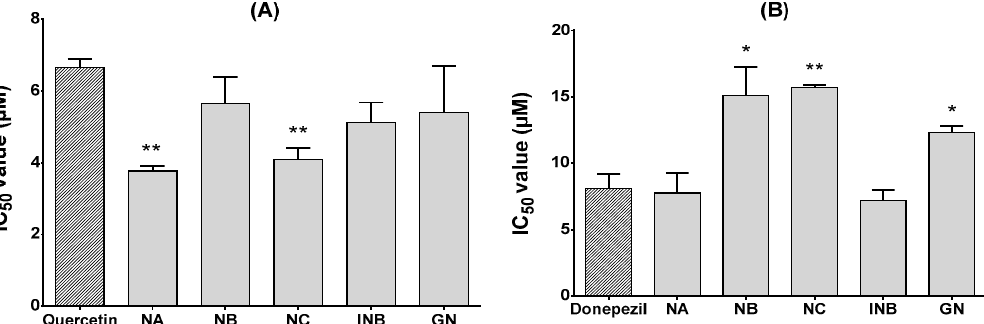
Figure 4. The α -glucosidase ( A ) and acetylcholinesterase ( B ) inhibitory effects of different Okinawa propolis (OP) compounds. Data represent means ± SE of three experiments. Asterisks indicate significant differences compared to the positive control (* p < 0.05; ** p <